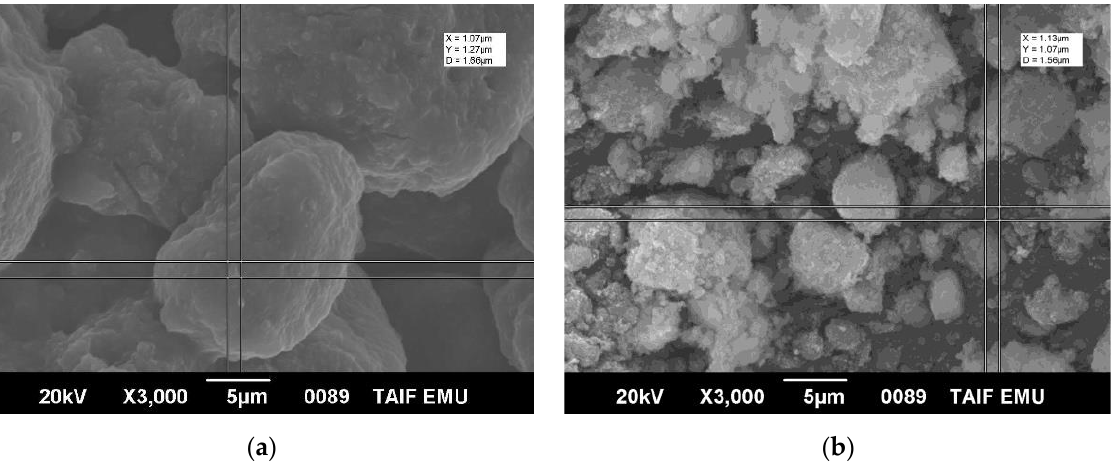
Figure 1. Scanning electron microscope photos showing the crystalline shape of nHAPs_PPE ( a ) and nHAPs_CE ( b ) at ×3000 magnification.